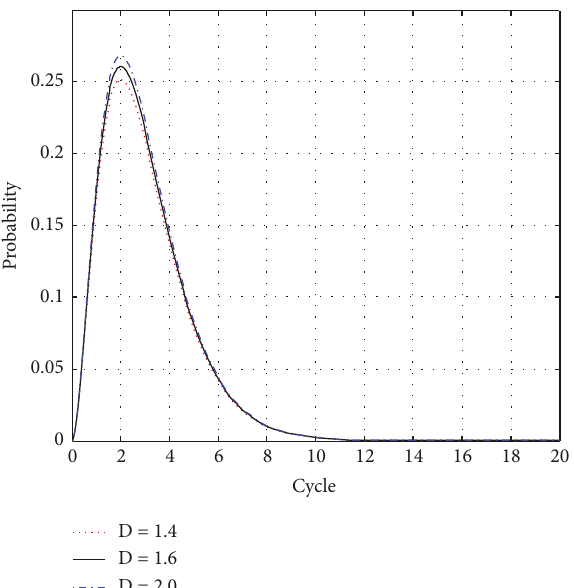
Figure 6: Sensitivity analysis of (P)